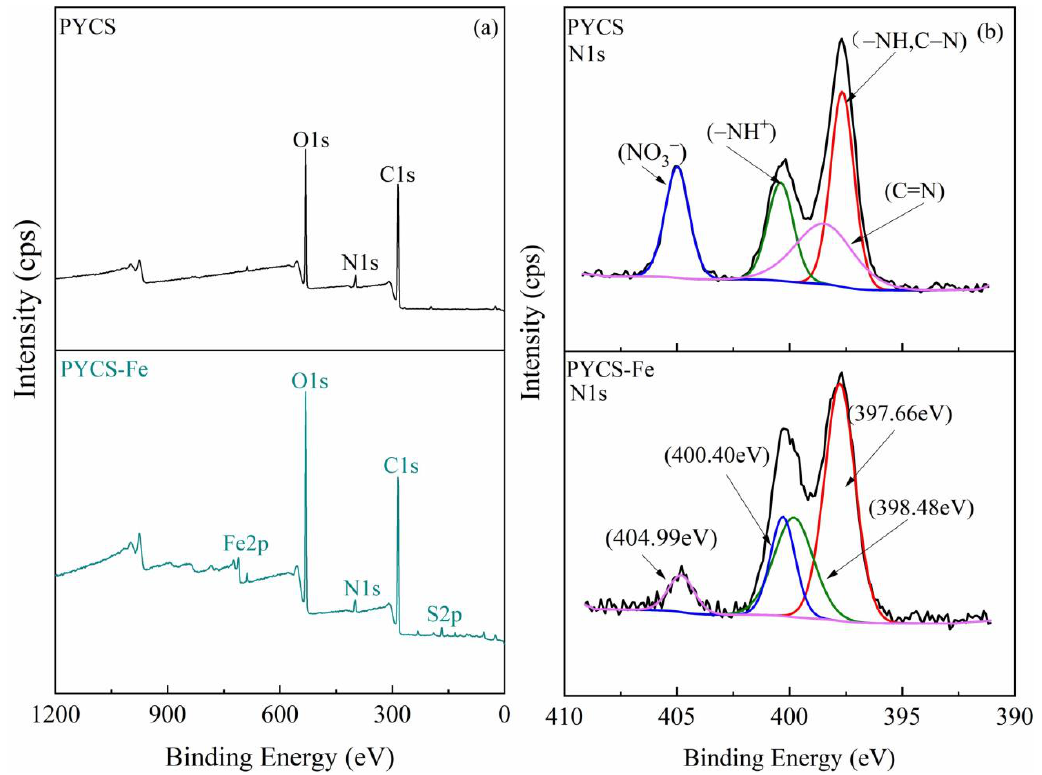
Figure 9. Characterization of PYCS before and after Fe (III) adsorption: ( a ) XPS wide scan spectra. ( b ) XPS spectra of N1s.